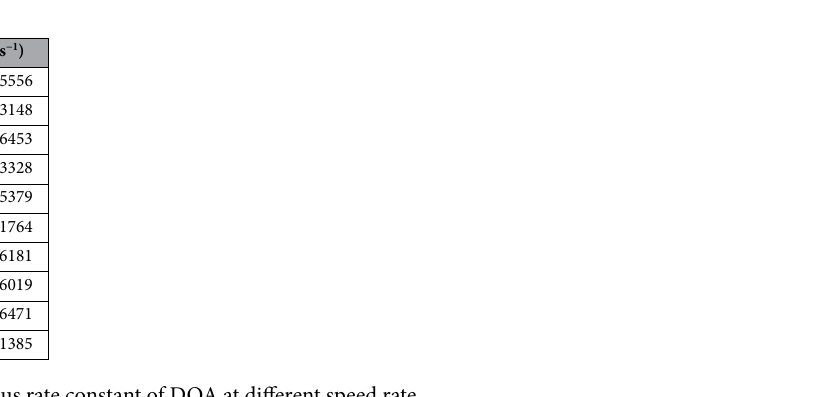
Figure 8A depicted the CV’s of DOA at Po-RD/Al-ZnO MCPE for different concentrations. The concentration of varied beginning in PBS (pH 7.4). The Ip of DOA hiked with hiking the concentration. The design of Ipa versus DOA concentration exhibits good linearity (Fig. 8B) and the lower limit of detection (LLOD) and limit of quantification (LOQ) is determined